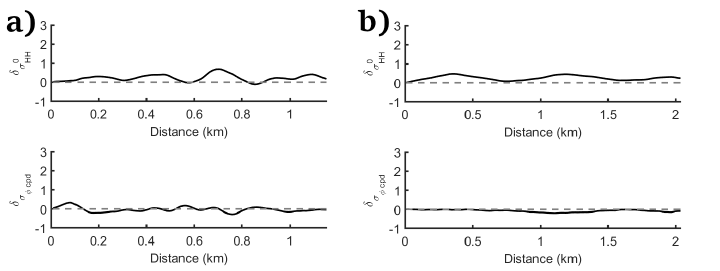
Figure 7. δ and δ σ profiles (upper and lower, respectively) associated to: ( a ) Image ID 2; and ( b ) σ 0 HH φ CPD Image ID 5 (Profile ID 5.1). The dotted green lines show the δ = 0; where l = l 0 .